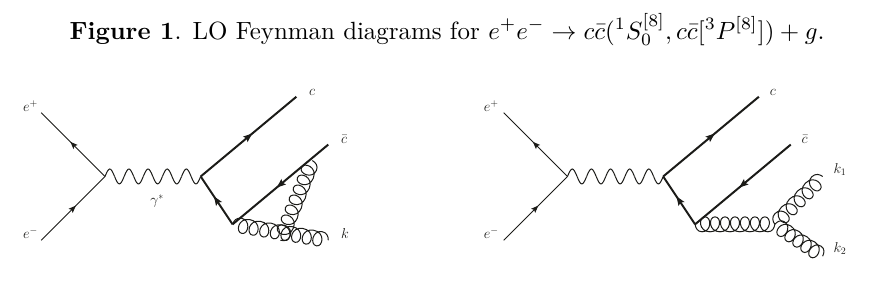
Figure 1 . LO Feynman diagrams for e + e − → c ¯ c ( 1 S [8]